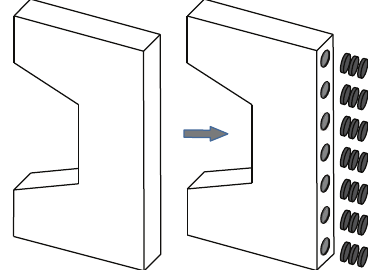
Figure 4: Sampling of concrete along the tension side of column